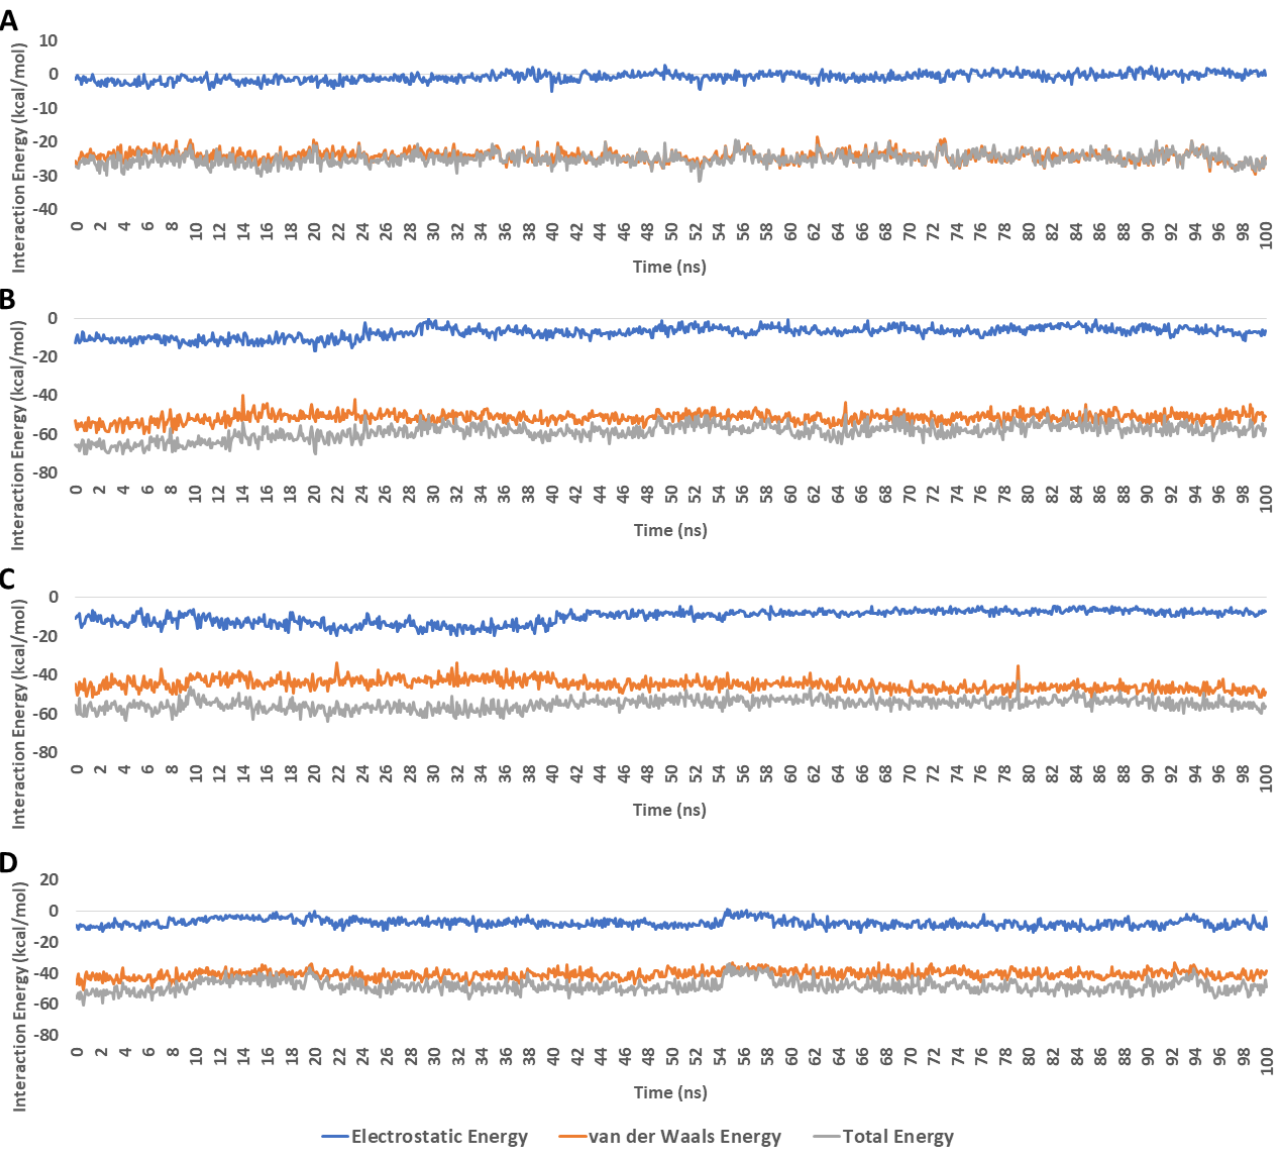
Figure 10. Interaction energies of calycopteretin-3-rutinoside, withanoside IX, and 4,16-dihydroxy- 5 β ,6 β -epoxyphysagulin D along with the co-crystallized inhibitor inside the active site of NMT throughout 100 ns MDS runs ( A – D ), respectively). The total interaction energy is the sum of both electrostatic and van der Waals energies.